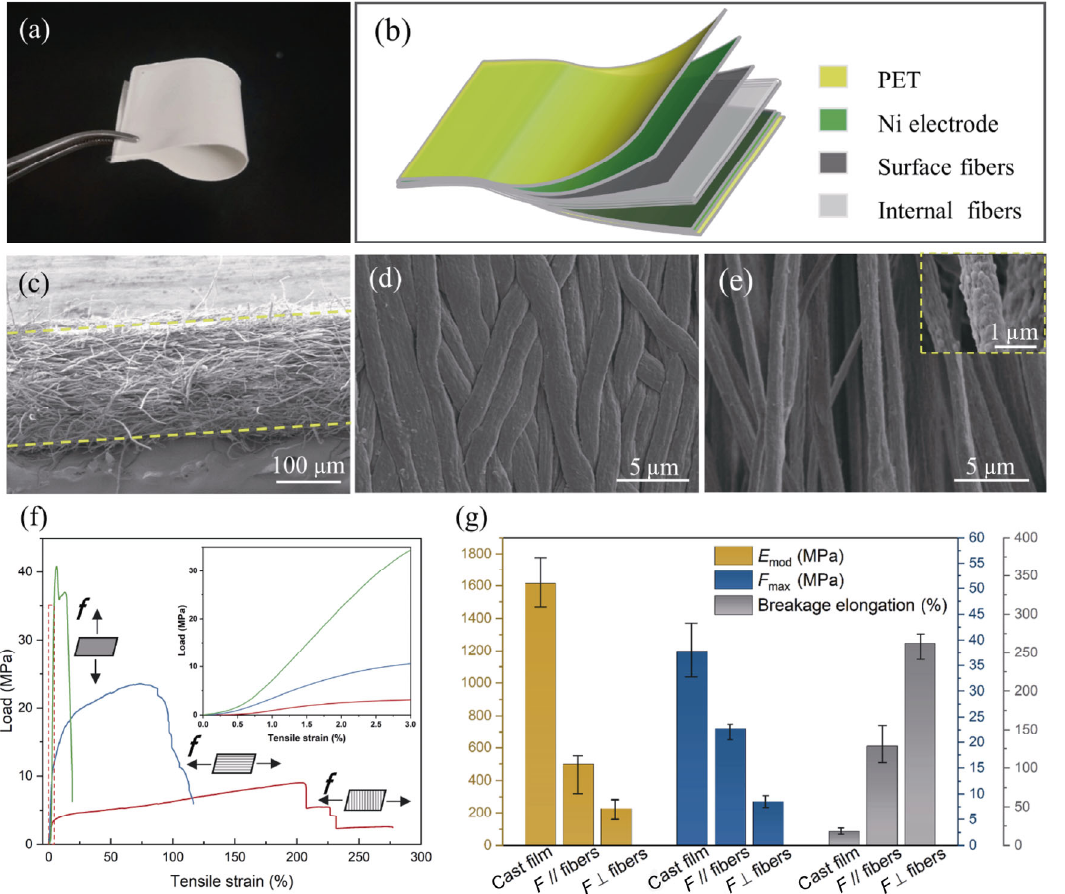
Fig. 3 (a) Photograph of the fiber film; (b) schematic structure of the PENGs; (c) SEM image of the fiber film cross section; (d) surface fibers; (e) internal fibers (the inset: the enlarged view of one single fiber); and (f) strain curves. (g) Young’s modulus E mod , maximum tensile strength F max , and breakage elongation of 10 wt% PZT/PVDF film with a thickness of ~220 μ